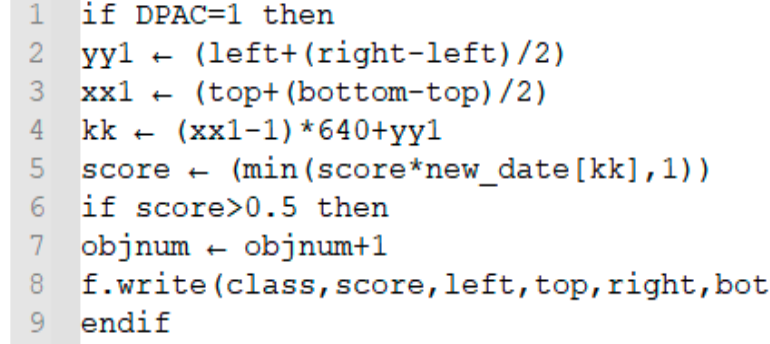
Figure 7. Confidence adjustment code.